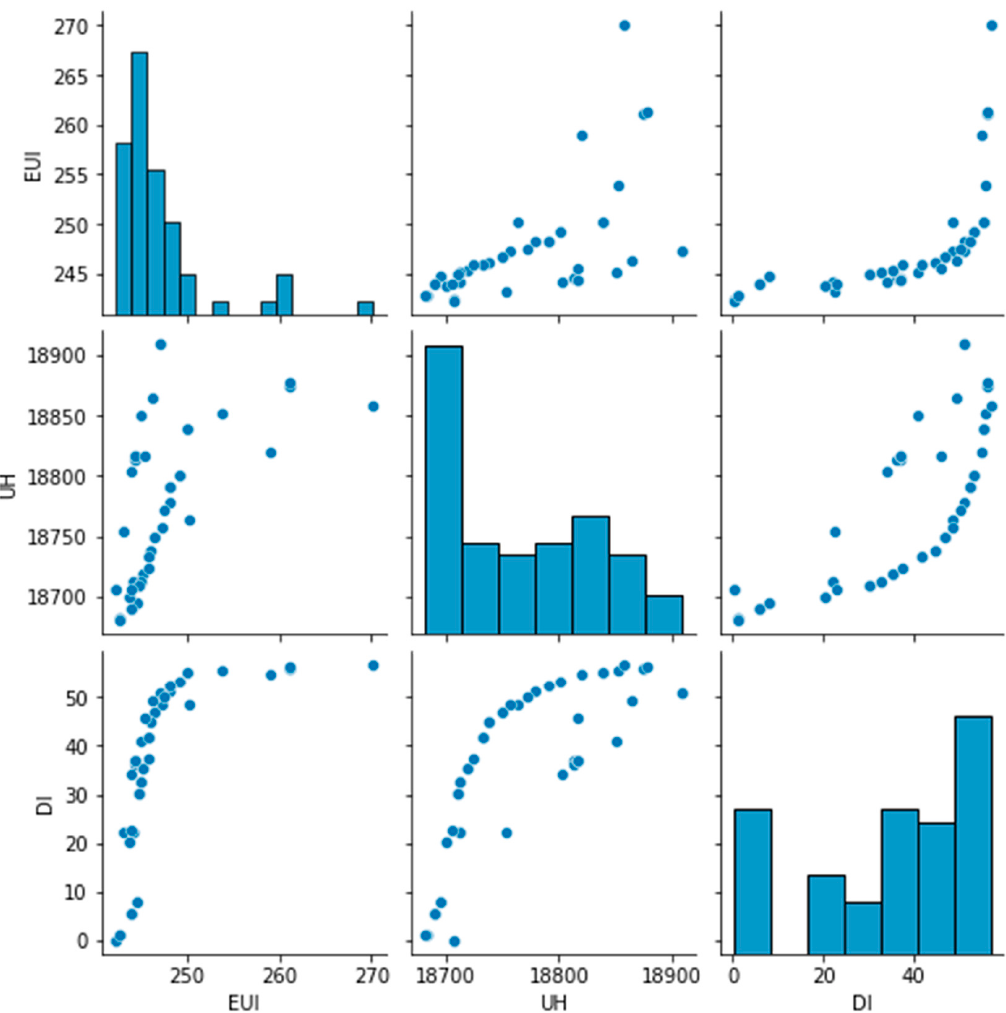
Figure 5. Histogram and correlation analysis of three optimization goals.